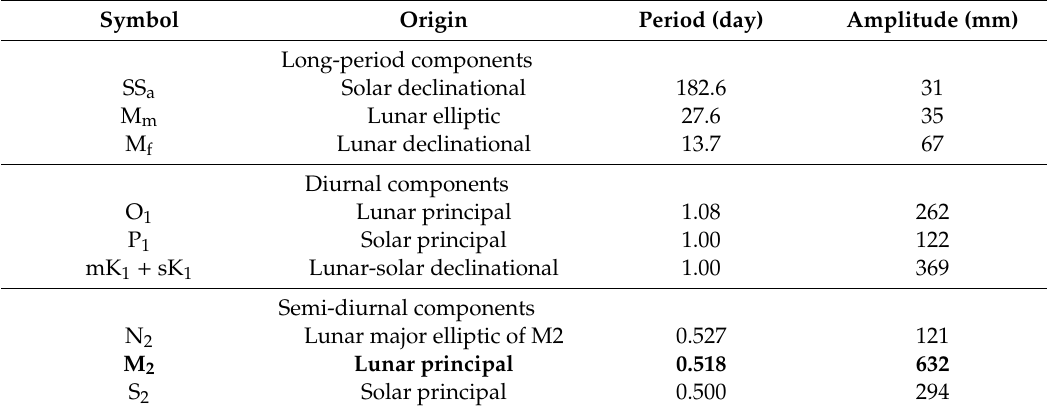
Table 1. Major earth-tide waves at the equator